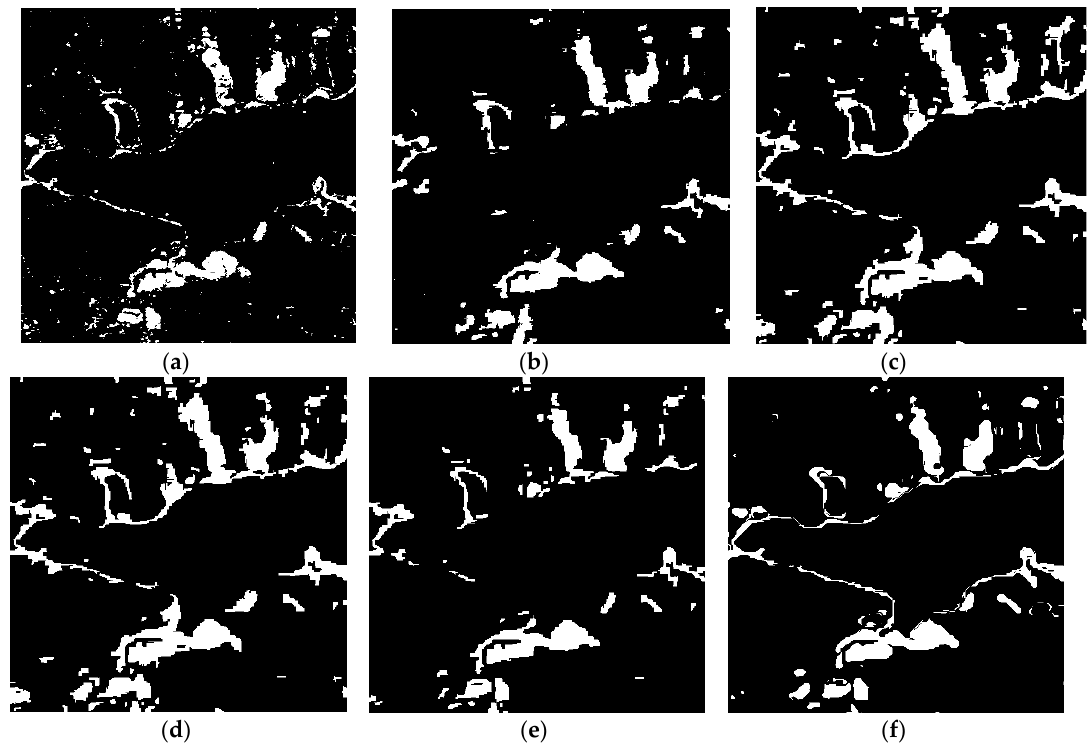
Figure 6. Change detection results of different algorithms over LiangZi Lake from 2011, 2015, and 2016. ( a ) Change detection result using OT_GGMM_pix ( k = 22). ( b ) Change detection result using